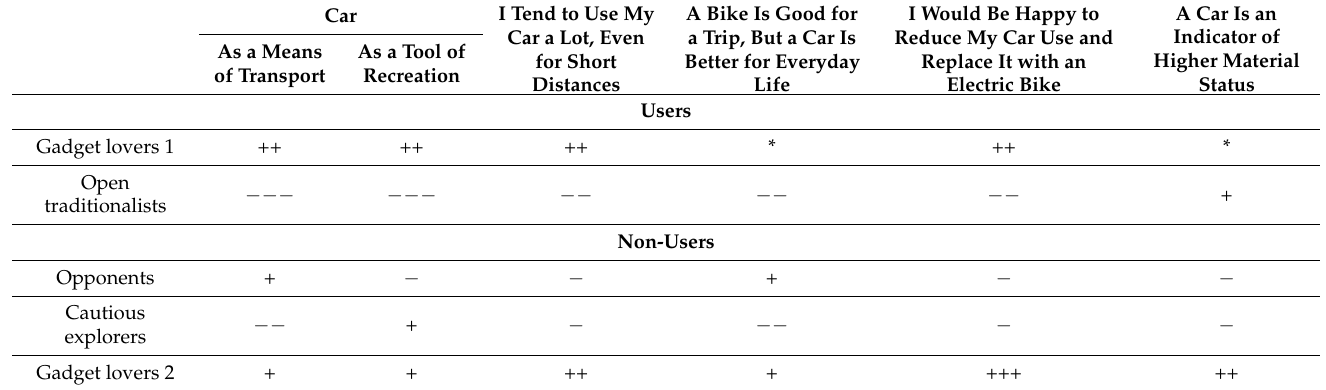
A Car Is an Indicator of Higher Material StatusAs a Means